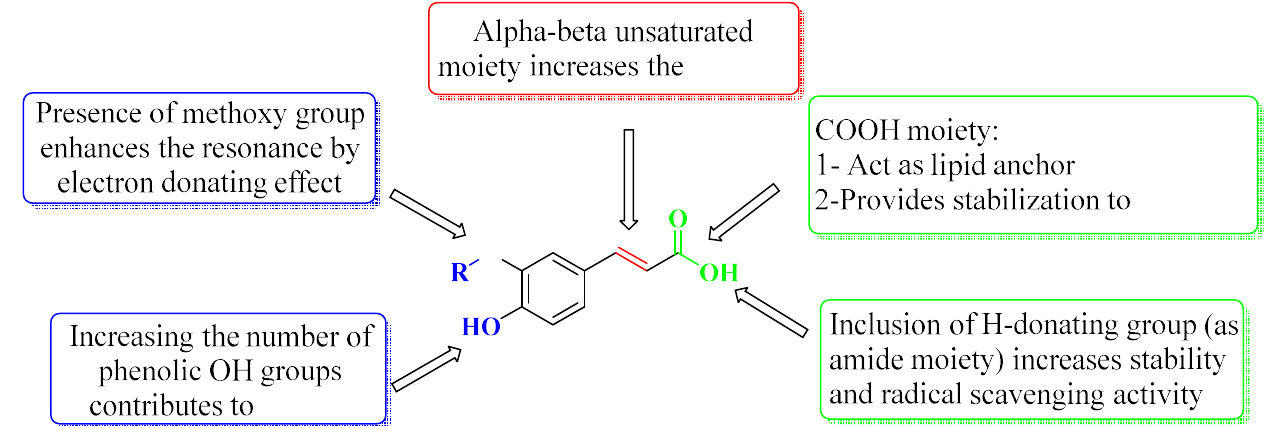
Figure 2. SAR of caffeic acid and ferulic acid as antioxidants.